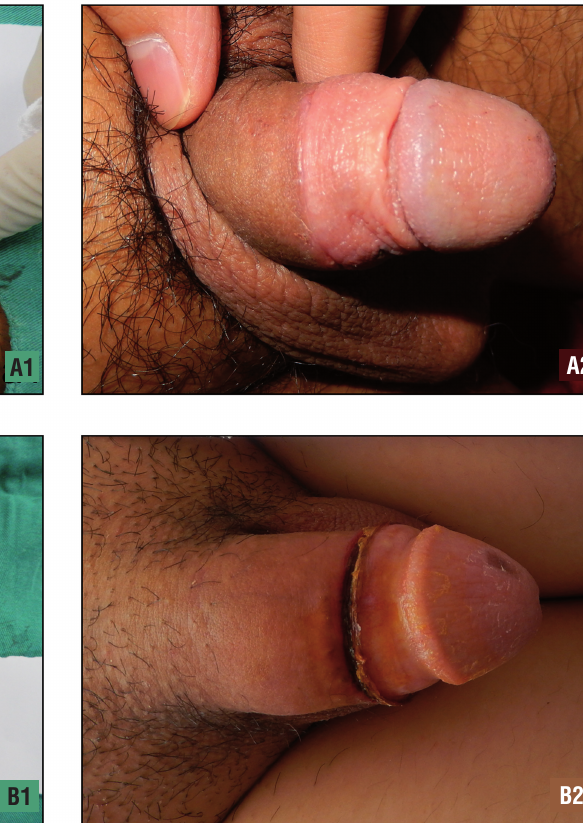
figure 3 - wound healing after operation: (a1, a2) wound healing results about 3 weeks in pcsD, (b1, b2) wound healing results about 3 weeks in